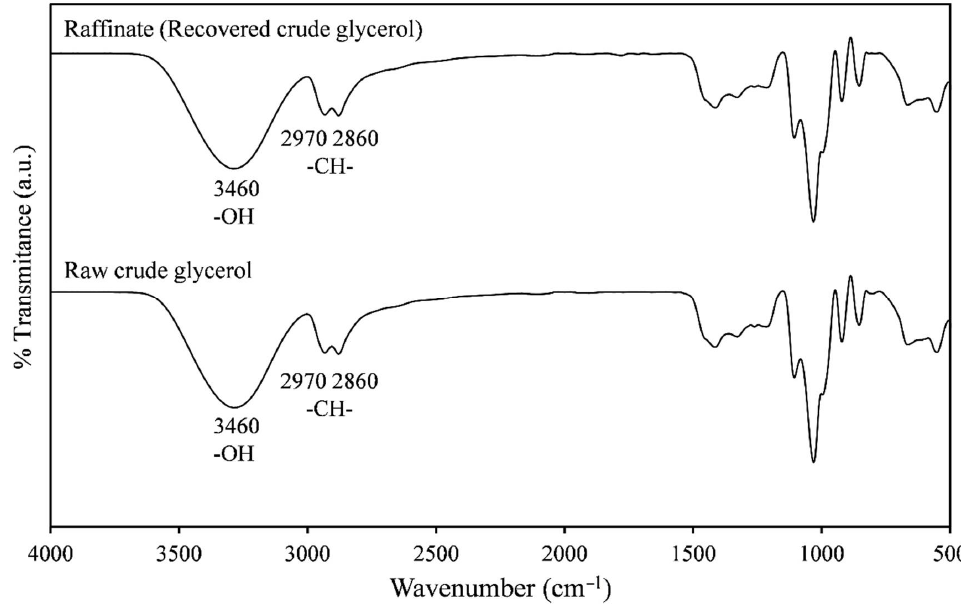
Figure 13. Comparison of FTIR spectra of the raw and recovered crude glycerol.